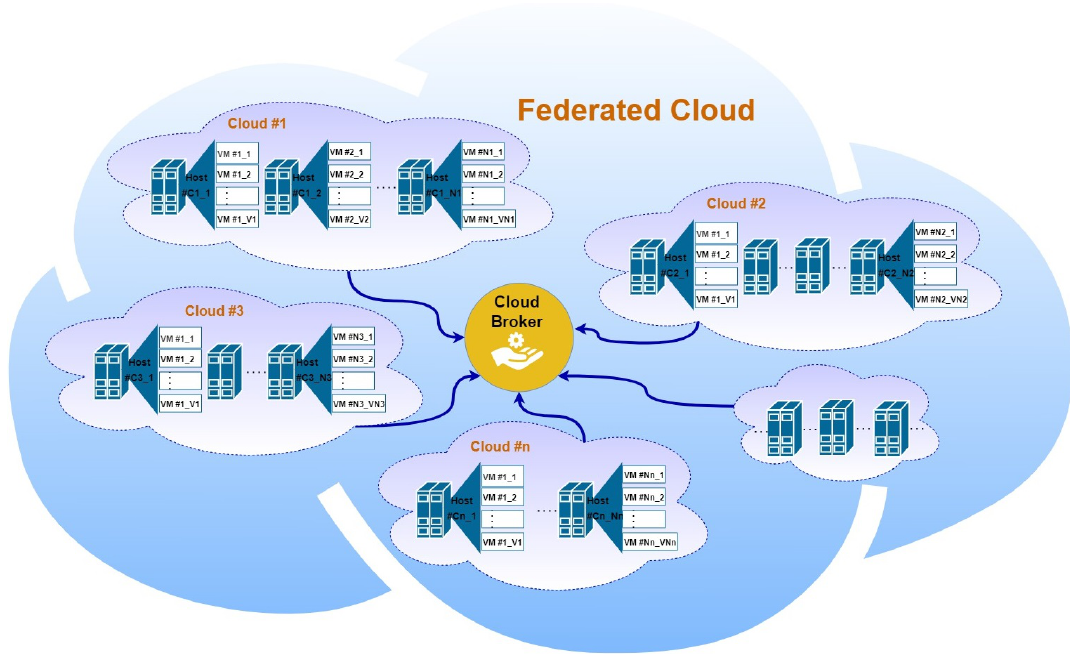
Figure 1. Architecture of federated